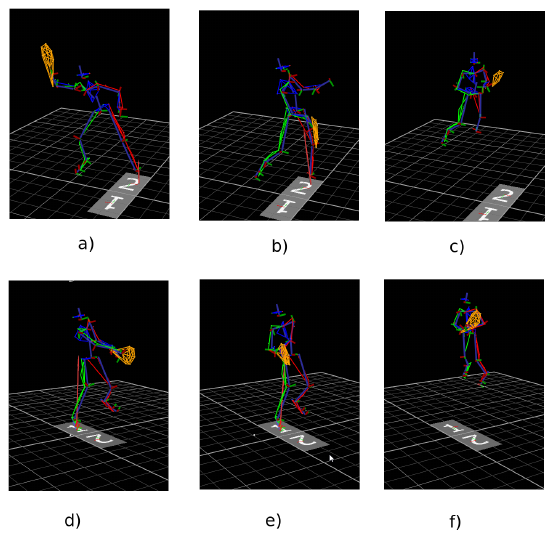
Figure 2. An example of forehand and backhand strokes ( a ) forehand preparation phase ( b ) forehand shot ( c ) no shot ( d ) backhand preparation phase ( e ) backhand shot ( f ) no shot. Each performed stroke has been verified by a specialist. All failed strokes were